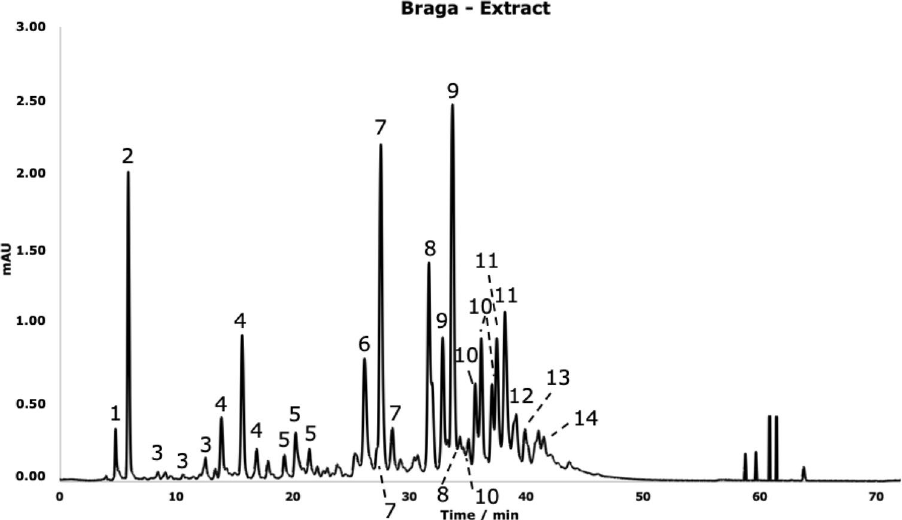
Figure 2. HPLC–ESI–MS chromatogram for the Braga extract, obtained using the gallotannin method (for more details, please see “Materials and